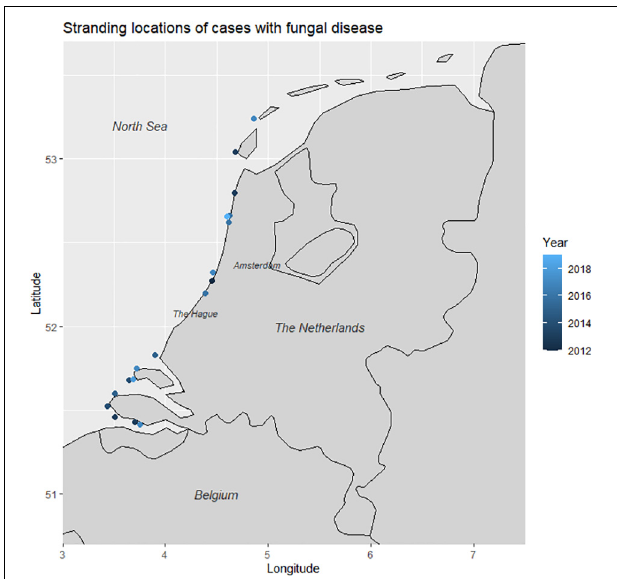
FIGURE 1 | Stranding locations of harbor porpoises diagnosed with fungal disease ( n = 18).